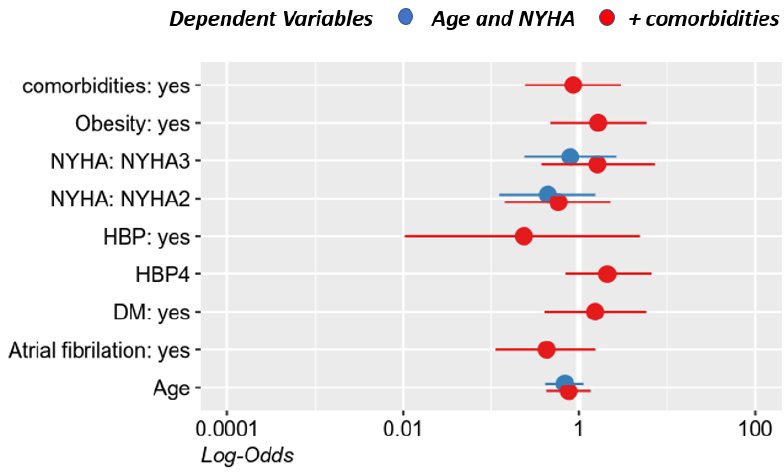
Figure 7. The prognosis of patients with ischemic heart disease and LBBB depending on the associated comorbidities. HBP: high blood pressure; HBP4: grades of hypertension; DM: diabetes mellitus.